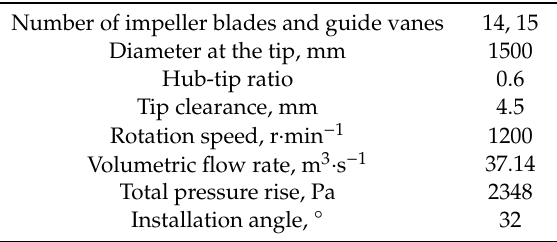
Table 2. Design parameters of the fan.